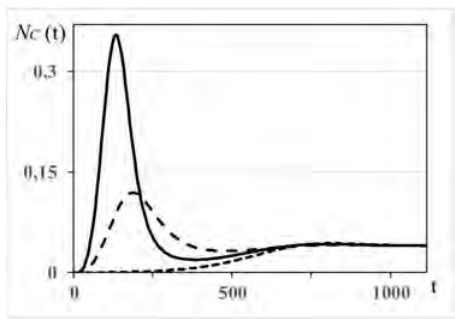
Fig. 11. Graphs of N C ( t ) for non-oscillating dynamics for 3 different initial values ϕ ( a ) .